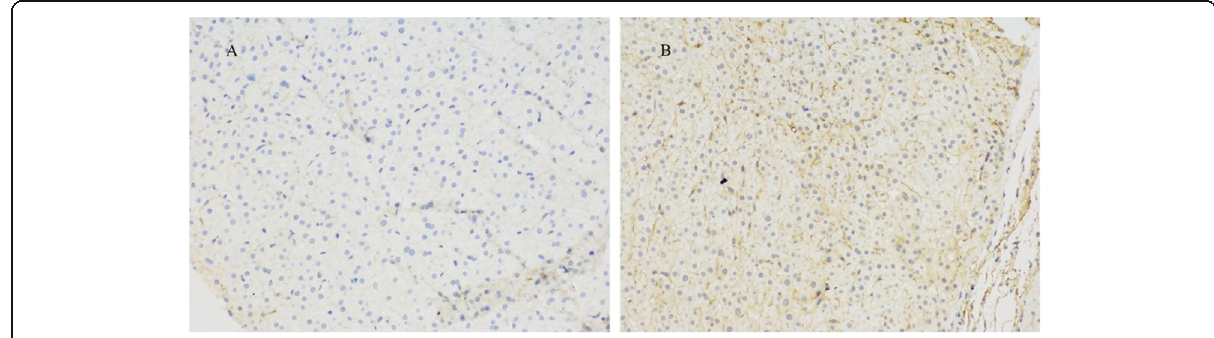
Fig. 2 Expression of the multidrug-resistant protein 3 in liver biopsy specimens. a : Liver biopsy specimens from the patient: MDR3 protein staining decreased significantly (immunohistochemical staining; original magnification × 200). b : Liver biopsy specimens from a healthy person showing strong staining and normal expression of the MDR3 protein (immunohistochemical staining; original magnification ×